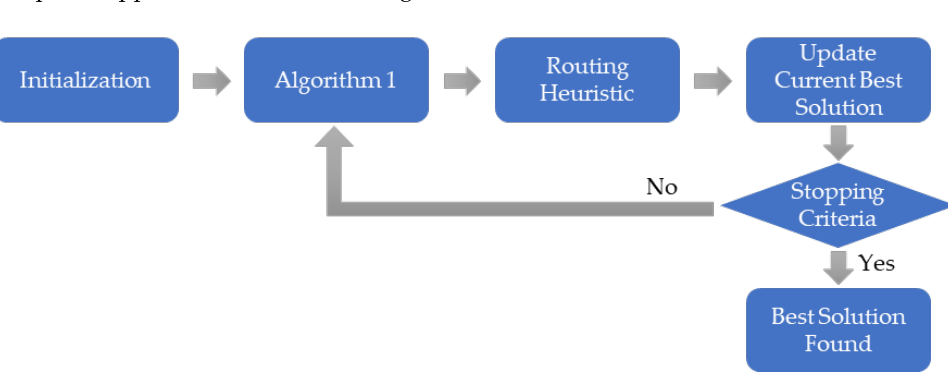
Figure 5. The overall procedure for the two-phase approach.